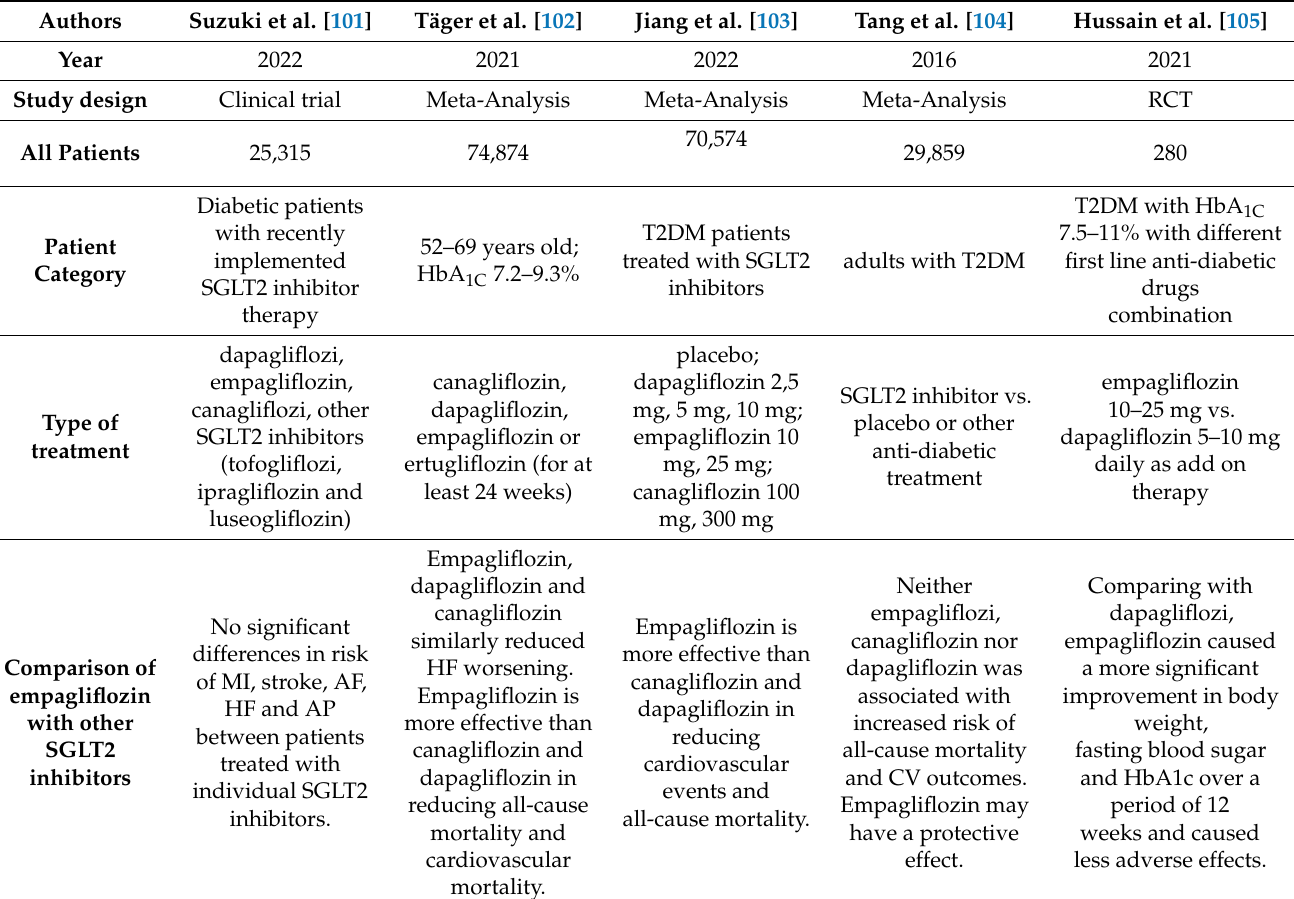
Table 3. Comparison of empagliflozin with other SGLT2 inhibitors in diabetic